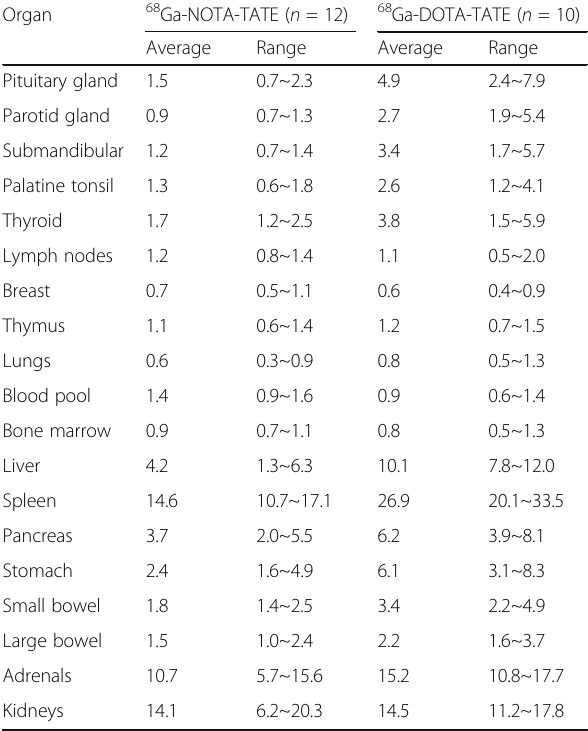
Table 2 Maximum standardized uptake values (SUVmax) of 68 Ga-NOTA-TATE and 68 Ga-DOTA-TATEPET/CT imaging in various organs of healthy volunteers Organ 68 Ga-NOTA-TATE ( n = 12) 68 Ga-DOTA-TATE ( n =